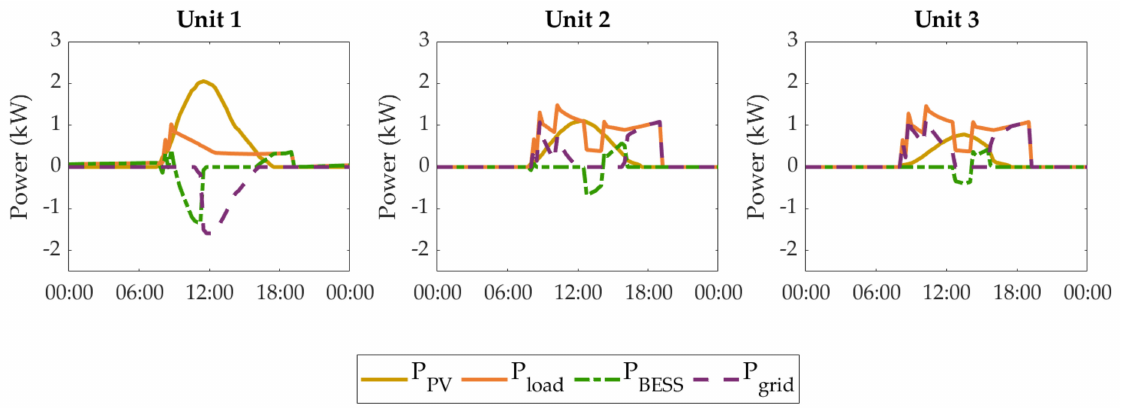
Figure 10. Power profiles of PV generation, electrical load, Battery Energy Storage System (BESS) charge/discharge and grid absorptions/injections during a typical winter day for the three